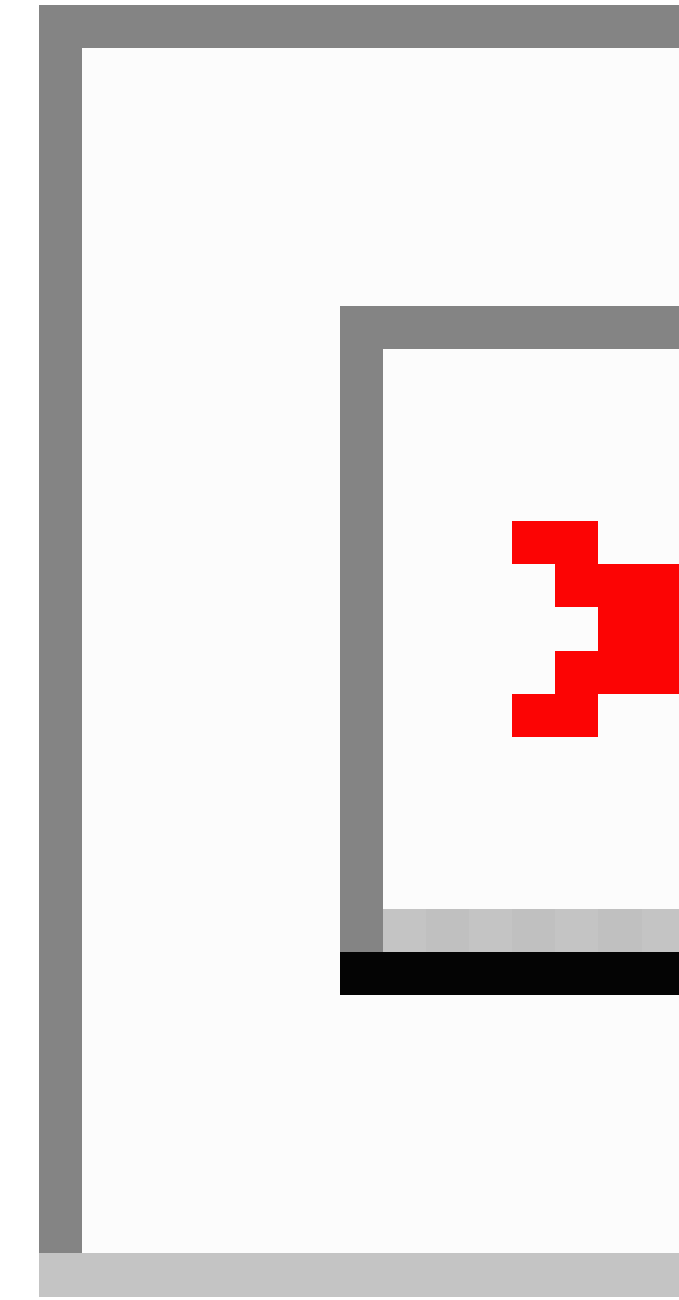
Figure 3. Accuracy of self-reported weight by percent weight change at 24